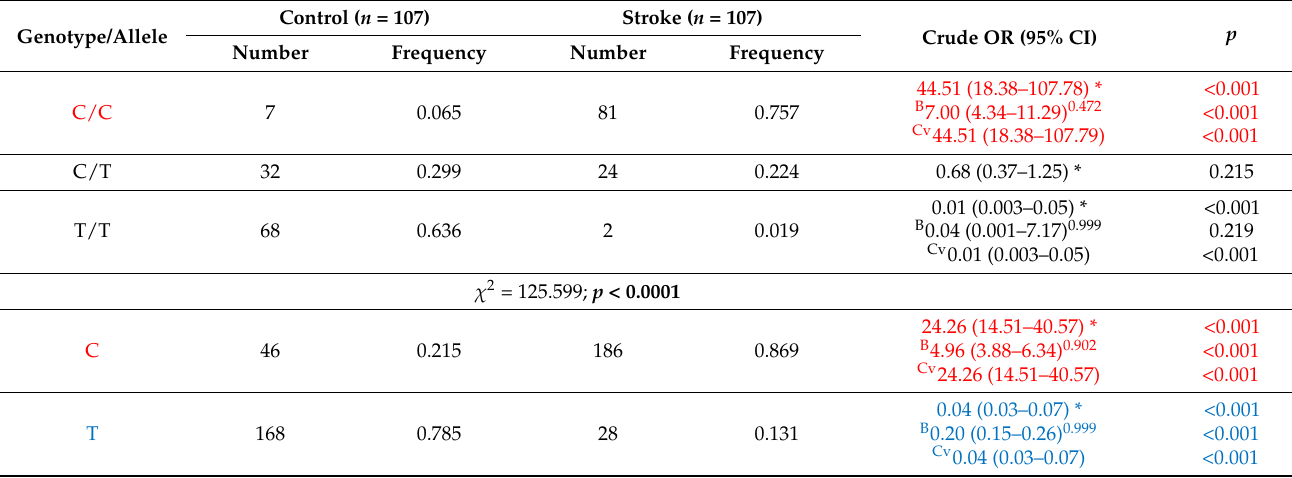
Table 6. Distribution of genotypes and alleles of the c.1823C > T (rs2297518) polymorphism in the NOS2 gene and odds ratios (ORs) with 95% confidence intervals (95% CIs) in patients with stroke and controls.